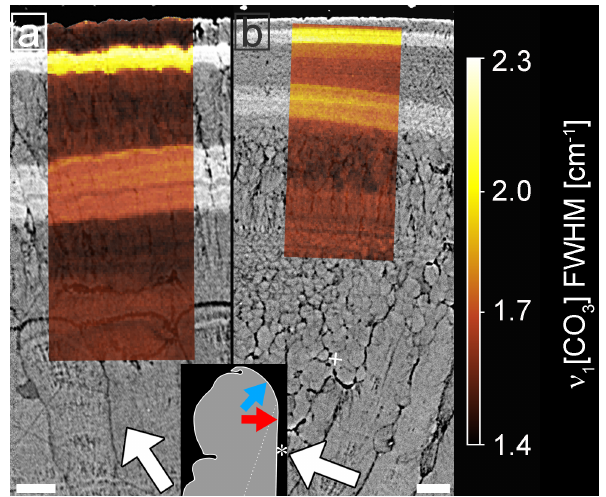
Figure 3. Micro-Raman maps (sample K2-04) showing the effect of Sr concentrations on the FWHM of peak ν 1 at 1084.8cm − 1 in the oOSL (a) and iOSL (b) . Raman maps are overlain on BSE images. White arrows identify the general growth direction of the shell, while the Sr-labelled shell layers from the underlying BSE image visualize the local growth directions for each ultrastructure. For micro-Raman maps of peak shifts see Fig. S2. All values are bandwidth corrected after Váczi (2014). A schematic of the shell tip shows the exact location of the Raman maps with blue and red arrows pointing towards the locations of the prismatic oOSL and crossed-acicular iOSL sampling locations, respectively. Aster- isk marks the inner shell surface. Scale bars are 10µm.